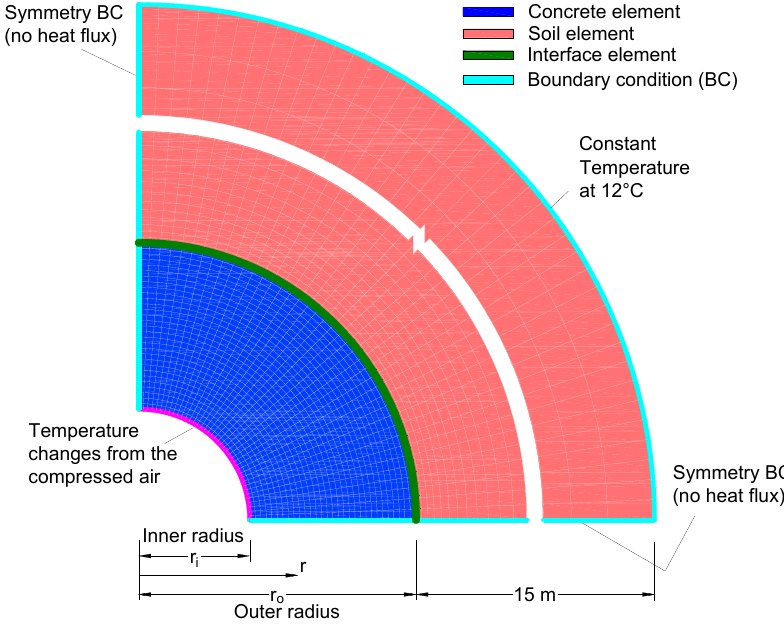
Figure 6. The 2D plane strain model.